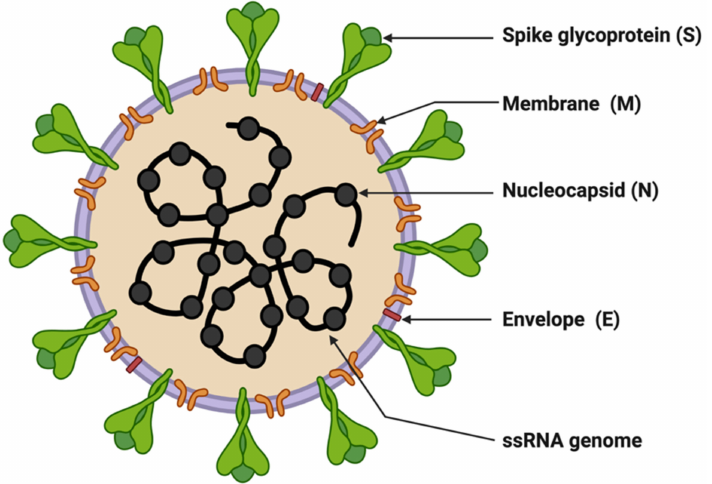
Figure 1. Structure of SARS-CoV-2. The figure was created with Biorender.com on 8 June 2022. Entry of SARS-CoV-2 into host cells is mediated by binding the receptor-binding domain (RBD) of the S protein to host cell receptors ACE2 and TMPRSS2, a serine protease that helps in the primming of the S protein [52,53]. ACE2 is present in the lung on pneu- mocytes II, indicating the lung as the primary target organ of SARS-CoV-2. In addition to this, ACE2 also catalyzes the conversion of regulatory peptides in the cardiovascular system, responding to maintain the homeostatic state, and this activity may account for the rationale behind fatal symptoms including pulmonary embolism or deep venous throm- bosis in severe COVID-19 patients [54]. However, the factors contributing to enhanced SARS-CoV-2 transmission are the efficient use of TMPRSS2 compared to SARS-CoV and the higher affinity for ACE2 owing to the modifications in the RBD leading to stabilizing virus-binding hotspots [44,52]. In addition, SARS-CoV-2 entry requires sequential cleavage of the spike glycoprotein at the S1/S2 and the S2’ cleavage sites to mediate membrane fusion. SARS-CoV-2 has a polybasic insertion (PRRAR) at the S1/S2 cleavage site that can be cleaved by furin (furin is a host-cell enzyme in human organs, such as the liver, the lungs, and the small intestines). These factors provide a mechanism called a spring-loaded manner of entry into the host cell, which prohibits endosomal trapping and is accountable for the higher transmissibility of SARS-CoV-2 compared to SARS-CoV [55]. The coronavirus spike (S) glycoprotein is a crucial target for vaccines, therapeutic antibodies, and diagnostics. The SARS-CoV-2 variants of concern (VOCs), Alpha, Delta, and Omicron, have mutations in the S1 subunit of the spike protein, which hosts the RBDs, hence altering the interaction of RBD with host-cell receptor ACE2, resulting in viral entry efficiency into the host cell (Table 1). The Alpha variant has ten modifications in the spike-protein sequence, which results in RBDs being more likely to stay in the ‘up’ position